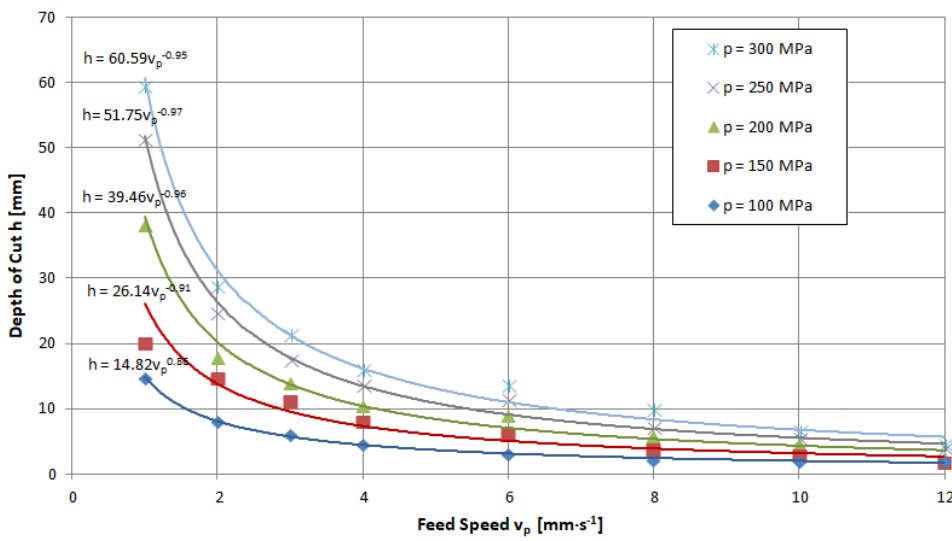
Figure 12. Influence of traverse speed and pressure on the depth of the cut of granite: nozzle internal diameter d w =0.25 mm, flow of abrasive m a = 6.7 g · s − 1 .